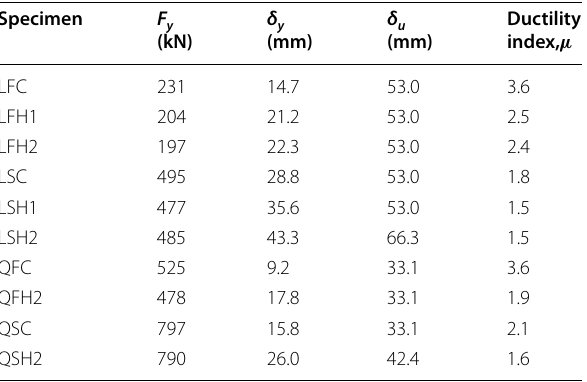
Table 6 Yield load, ductility index and displacement obtained from the